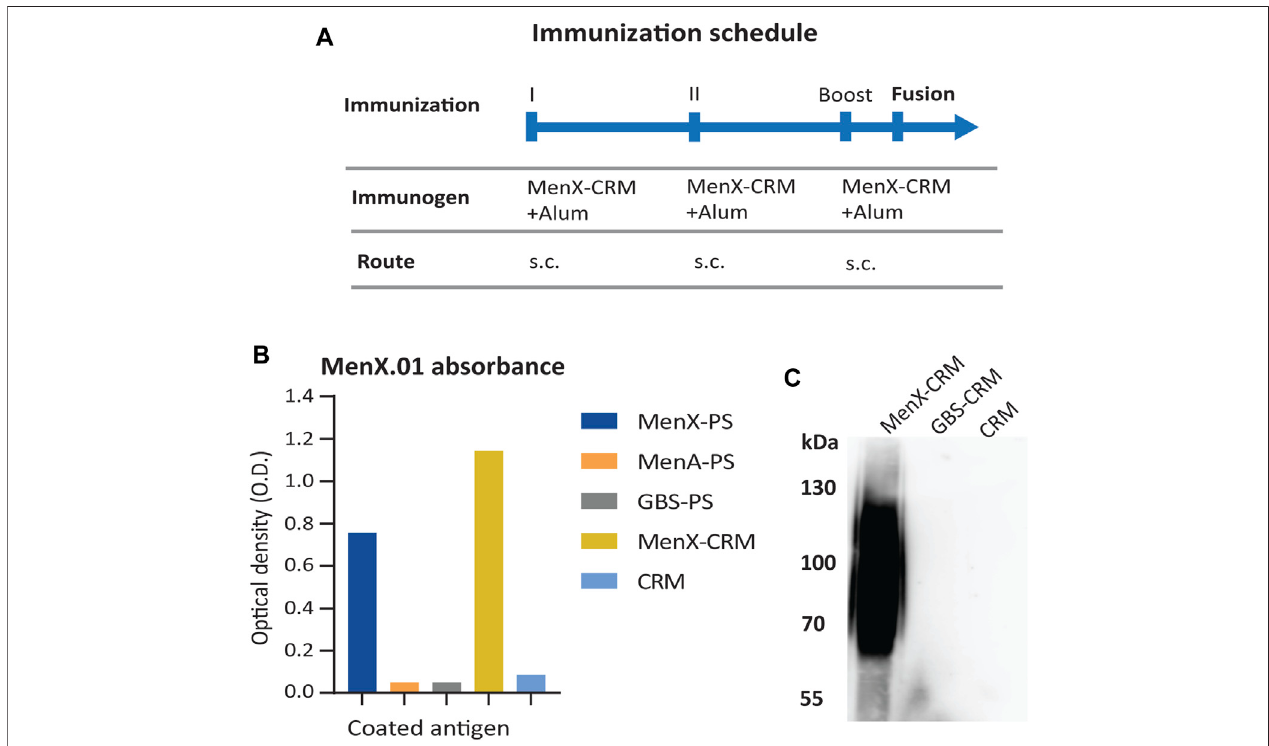
FIGURE 1 | Speci fi city of the supernatants from the hybridoma cells producing mAb MenX.01 against the MenX polysaccharide. (A) MenX immunization protocol. (B) Cross-speci fi city test of puri fi ed MenX.01 mAb on ELISA plates coated with i) MenX-PS, ii) i) MenA-PS, iii) GBS-PSII, iv) MenX-CRM 197 conjugate, and v) CRM 197 protein. (C) MenX-CRM 197 molecules were detected by western blot/imunoblot using MenX.01 mAb, followed by anti-mouse Fab-HRP. As a negative control, CRM 197 and GBS PSII-CRM 197 were